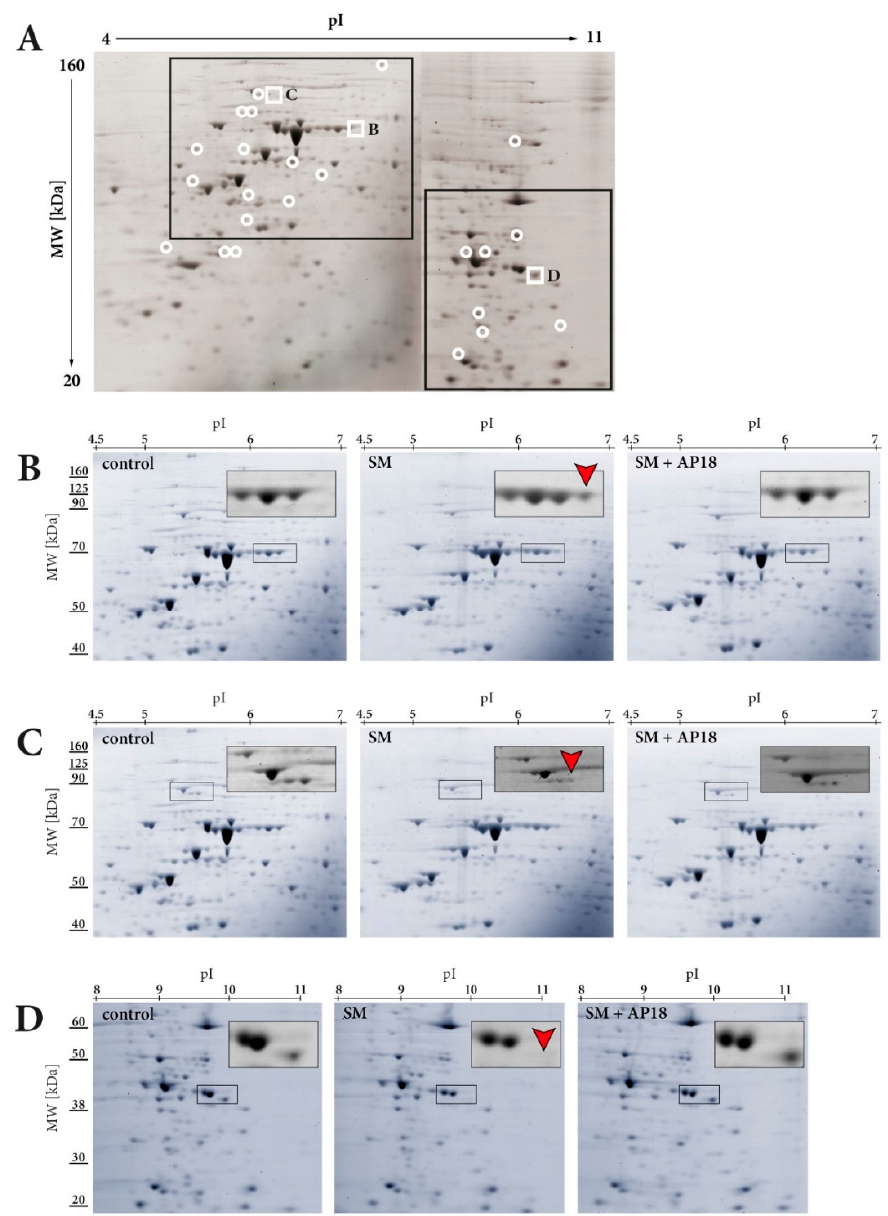
Figure 1. Representative 2D CBB-stained gel electrophoresis of HEKA1 cells. The proteome of HEKA1 control, 600 µM SM-exposed or 2 µM AP18-pre-incubated and SM-exposed cells was investigated. Isoelectric focusing of cell lysates was performed by 7 cm strips (pH 4–7 and pH 6–11, linear). Proteins were separated by 10% Bis-Tris gels. ( A ) Overview gel displaying 22 differential protein spots after SM exposure compared to controls (white open circles). White frames indicate three SM-induced and TRPA1-regulated proteins. ( B ) Zoom of the HSPA6 spot and ( C , D ) zoom of the two protein spots which proteins are listed in Table 1. Experiments were carried out with n = 3 per group. Molecular weight is indicated on the left and the pI value on top of the gels.